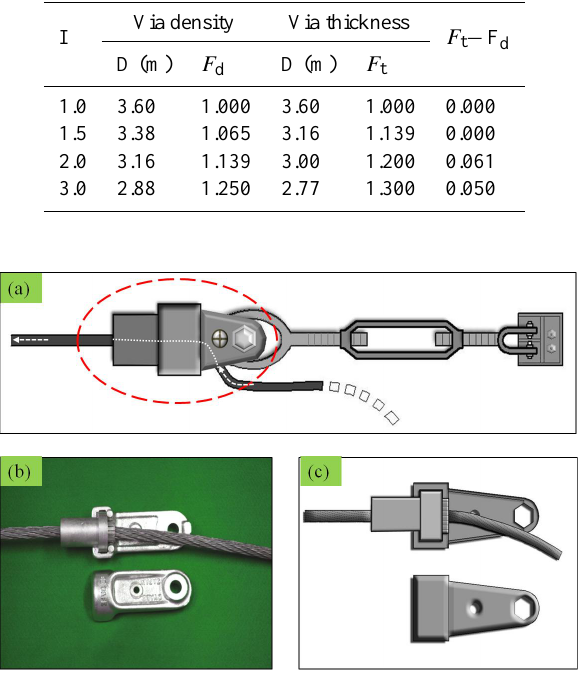
Figure 8. The UFD device used in the LPR structures. (a) Schematic diagram of the device integrated with cable and finally anchored at the end. (b) A photo of the disassembled device. (c) Schematic drawing of the disassembled device.